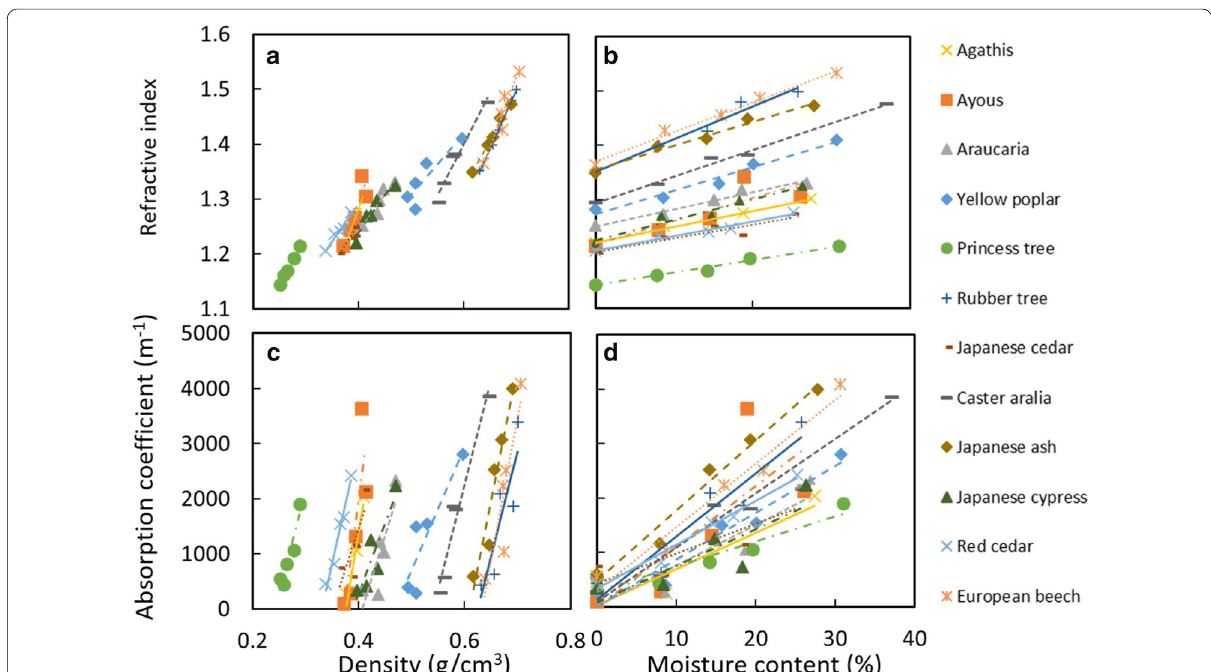
Fig. 3 Relationship between the refractive index and the a density, b moisture content and absorption coefficient, c density, and d moisture content. The regression lines are drawn for each